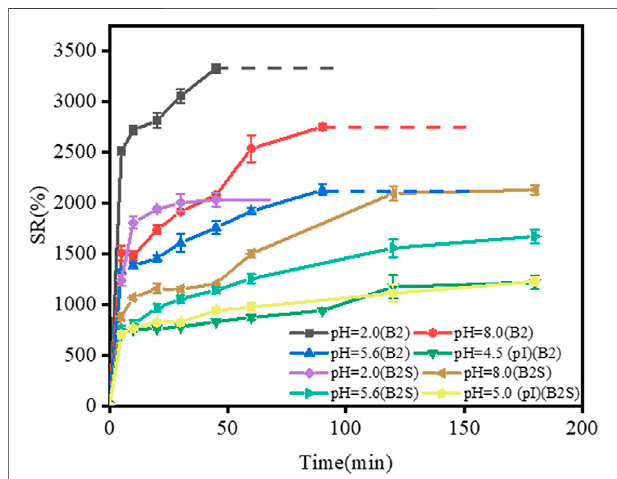
FIGURE 7 | Swelling curve of gelatin fi lms (B2 and B2S) at pHs of 2, 5.6, 8, and the pH of the gelatin fi lms pI. Dotted lines represent the dissolution